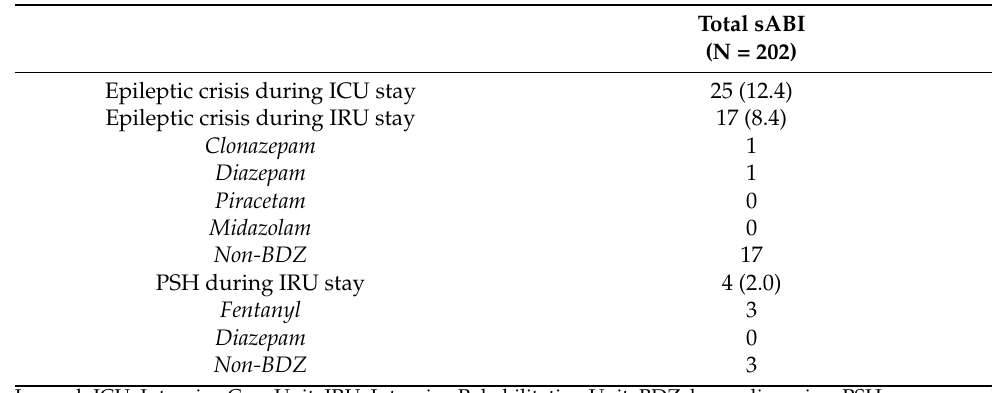
Table 4. Descriptive statistics for epileptic (during ICU and IRU) and neurovegetative crisis (during IRU). Specific numerosity is provided for patients intaking benzodiazepine-based drugs (BDZ). One patient may take more than one anti-epileptic medication. With paroxysmal sympathetic hyperactivity (PSH), it is intended as referring to a state of excessive sympathetic nervous system activity characterized by sudden increases in heart rate, blood pressure, respiratory rate, temperature, dystonia, rigidity and